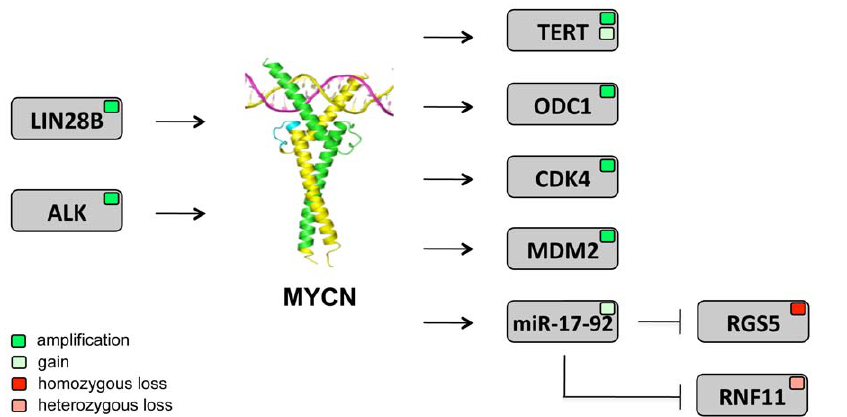
Figure 3. Rare recurrent focal copy number changes in neuroblastoma target up and downstream MYCN pathway components. Illustration of genes in focal genomic gains (light green) and amplifications (dark green) that are direct up regulated MYCN target genes or upstream regulators of MYCN and genes in focal heterozygous (light red) and homozygous (dark red) deletions which are down regulated by MYCN through its activated miRNAs. Protein structure was obtained from www.pdbe.org.